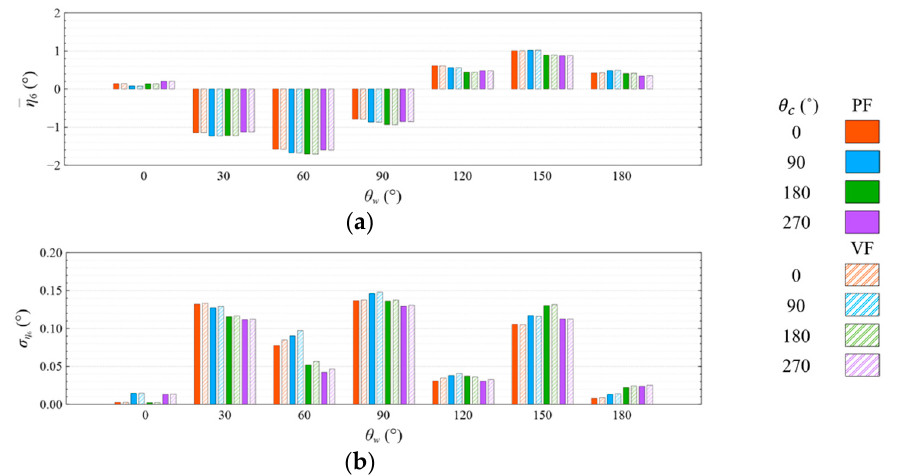
Figure 19. Comparison of ( a ) means and ( b ) standard deviations of platform yaw motion under CW condition.